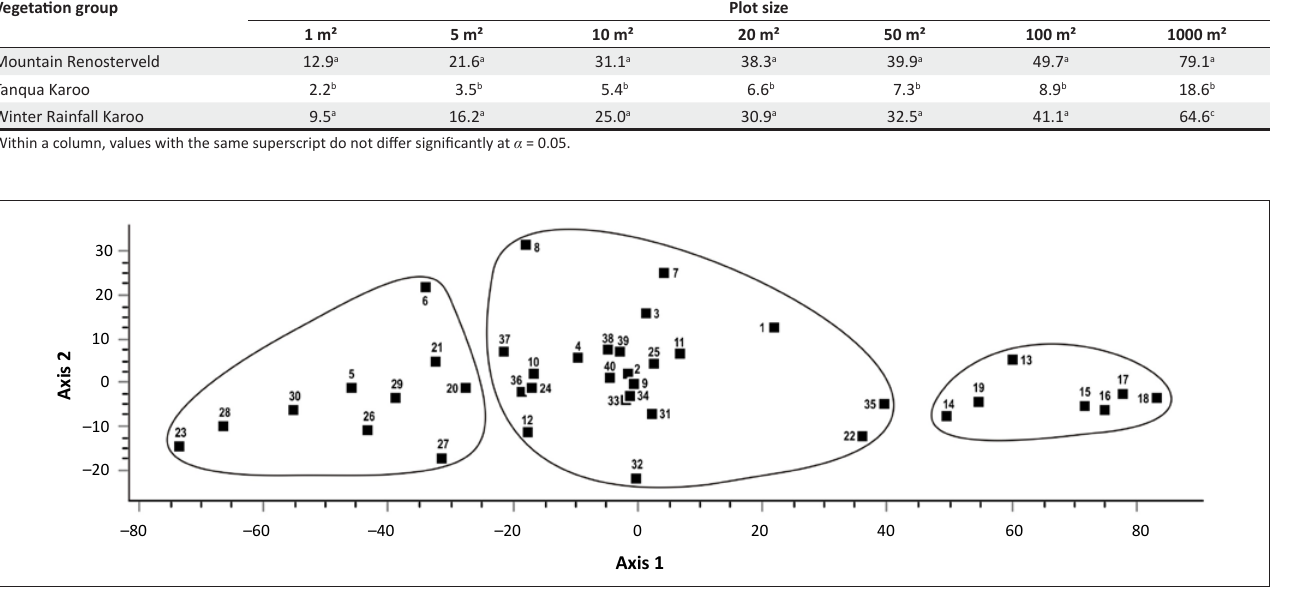
FIGURE 2: Scatter plot produced by principal coordinate analysis of species richness values for seven plot sizes across 40 plots surveyed in the Hantam, Tanqua and Roggeveld areas in 2005. Numbered data points denote survey plot numbers. Rainfall Karoo and Mountain Renosterveld plots varied quite considerably with increasing plot size. For example, plot W7 had a mean of 4.6 species within 1 m 2 and 79.0 species within 1000 m 2 , whereas plot W32 had three times as many species (14.4 species) within 1 m 2 but only 47.0 species within 1000 m 2